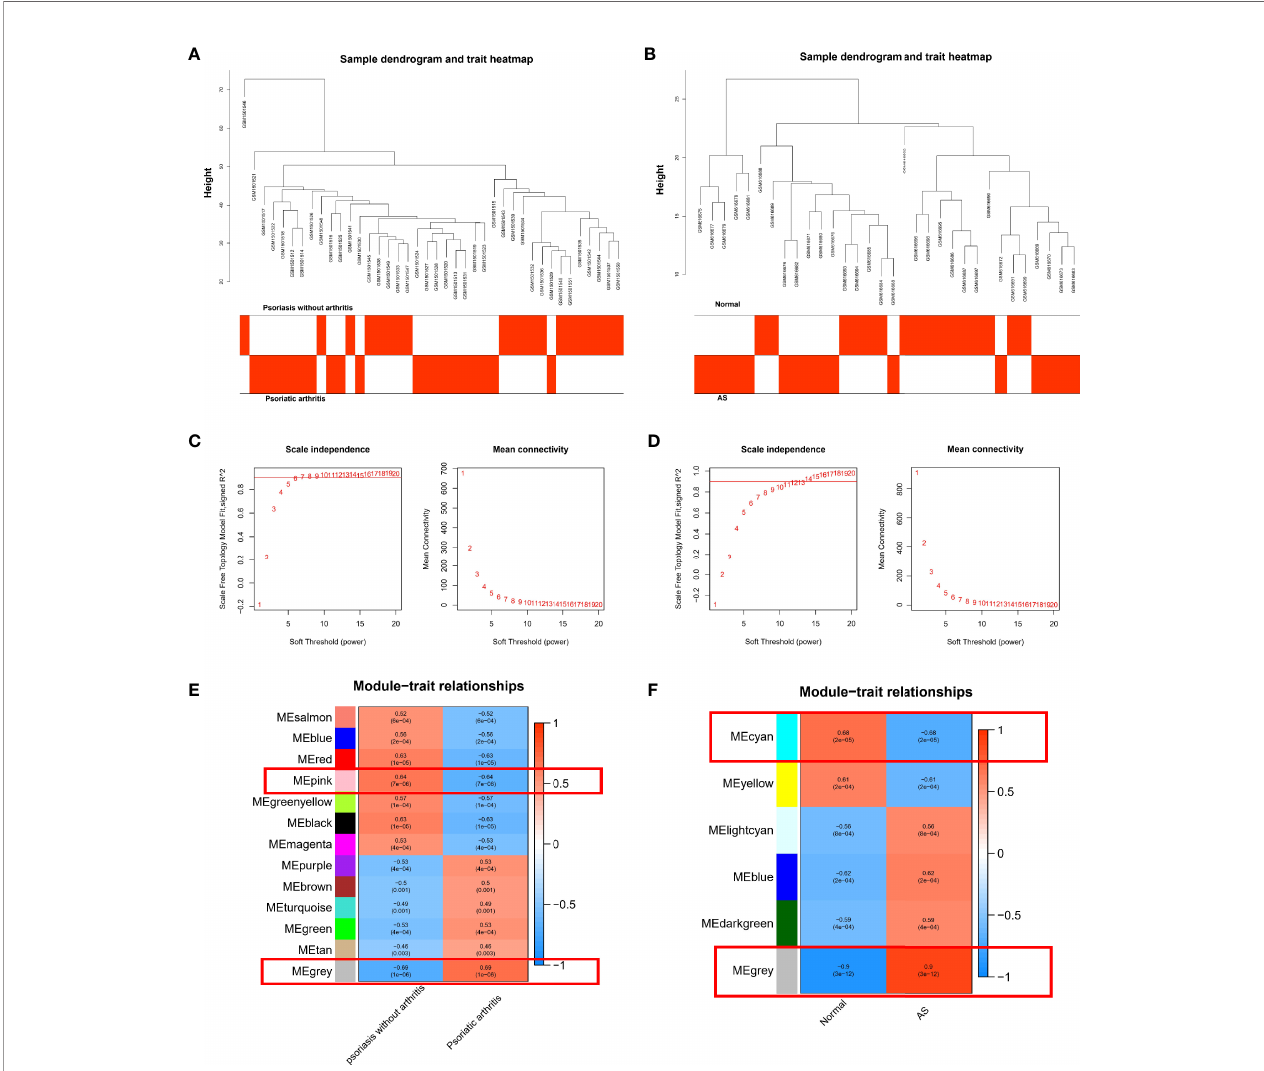
FIGURE 2 | (A) Correlation between modules and genes in GSE61281. (B) Correlation between modules and genes in GSE25101. (C) Determination of soft- thresholding power for GSE61281. (D) Determination of soft-thresholding power for GSE25101 . (E) Heatmap of the correlation between module eigengenes and the occurrence of PsA. (F) Heatmap of the correlation between module eigengenes and the occurrence of